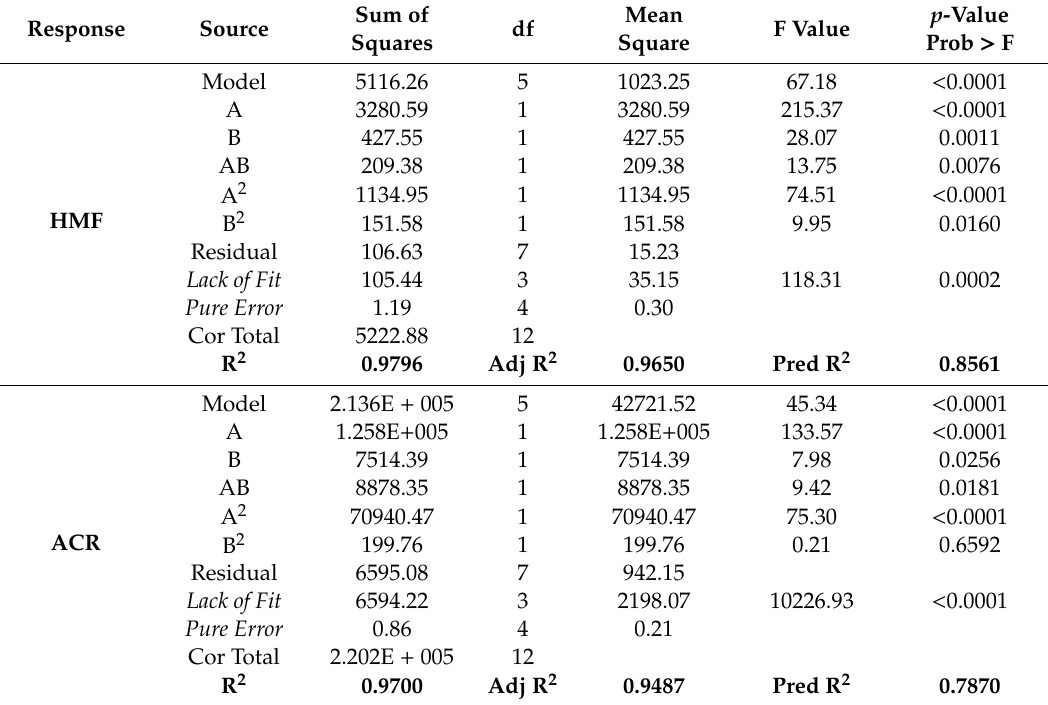
Table 4. Analysis of variance for response surface quadratic